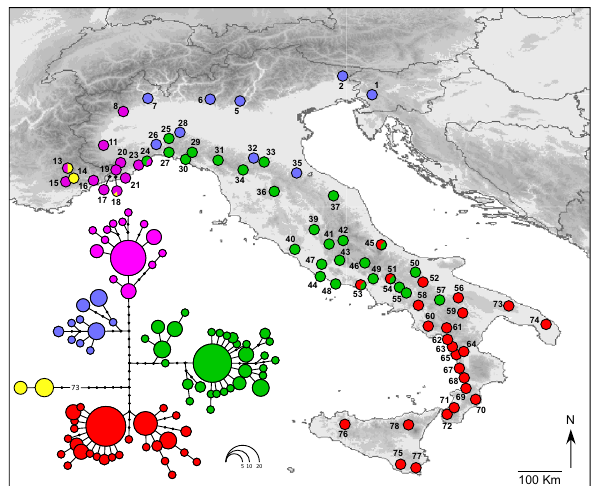
Figure 1. Maximum likelihood phylogenetic network of the Bufo bufo mitochondrial haplotypes found in Italy, and geographic distribution of the main haplotype groups. Circle sizes are proportional to haplotype frequency, and black dots represents missing intermediate haplotypes. Populations are numbered as in Table 1. The map was drawn using the software Canvas 11 (ACD Systems of America, Inc.).